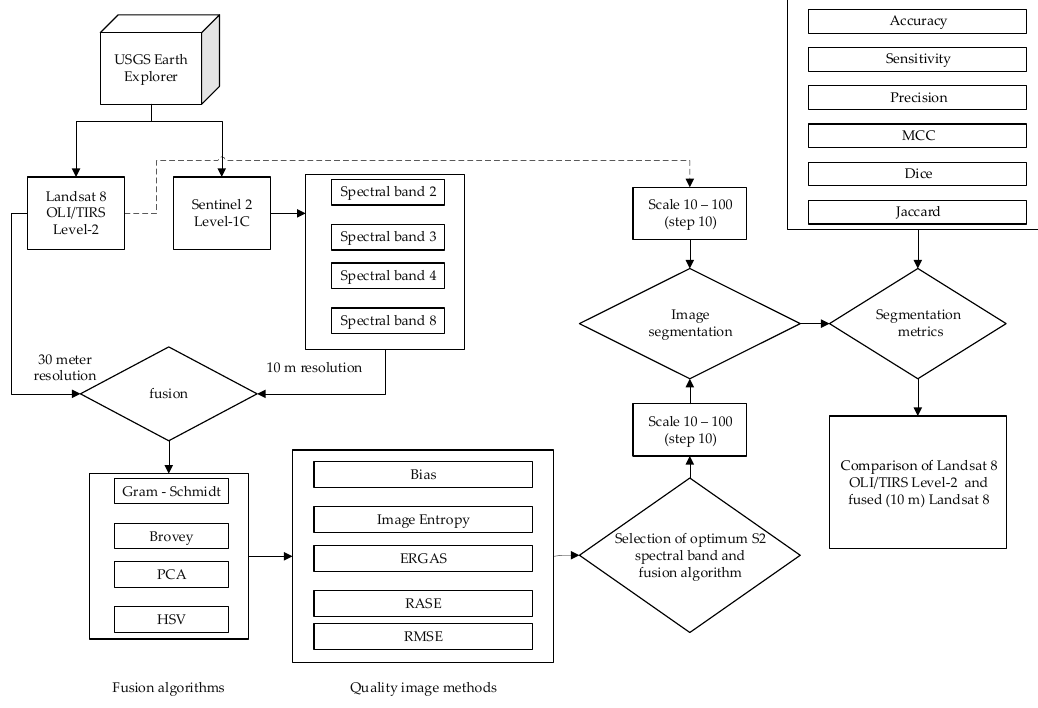
Figure 2. Overall methodology implemented in the study.